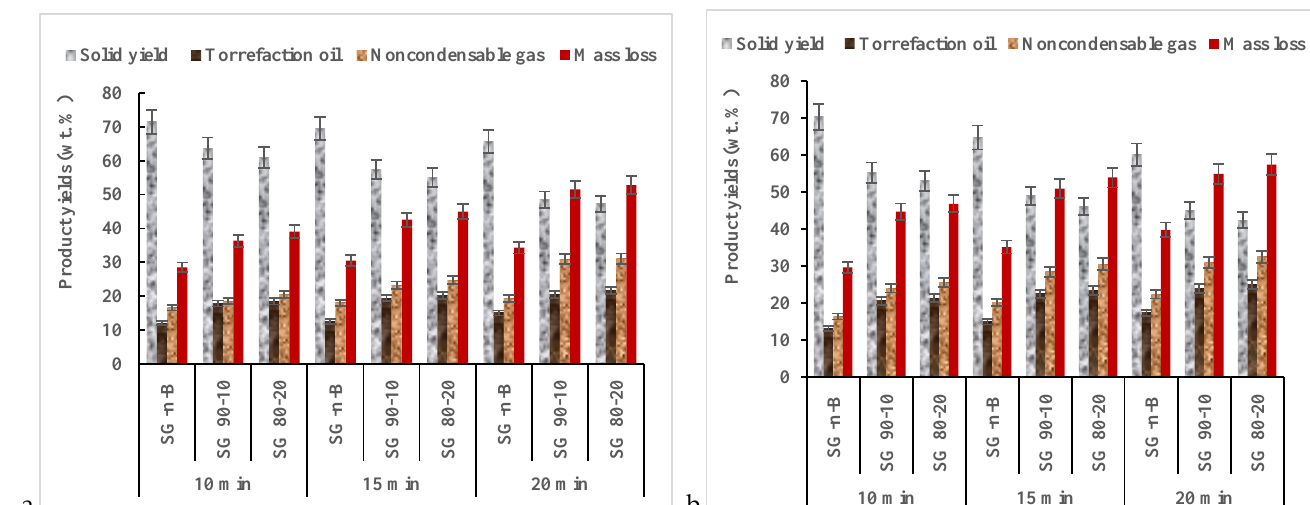
Figure 5. Fraction yields and mass losses of microwave torrefied switchgrass-biochar-mix at ( a ) 520 W and ( b ) 650 W. SG: switchgrass; SG-n-B: switchgrass-no-biochar. The first number after the biomass is % of biomass, and the second number is % of